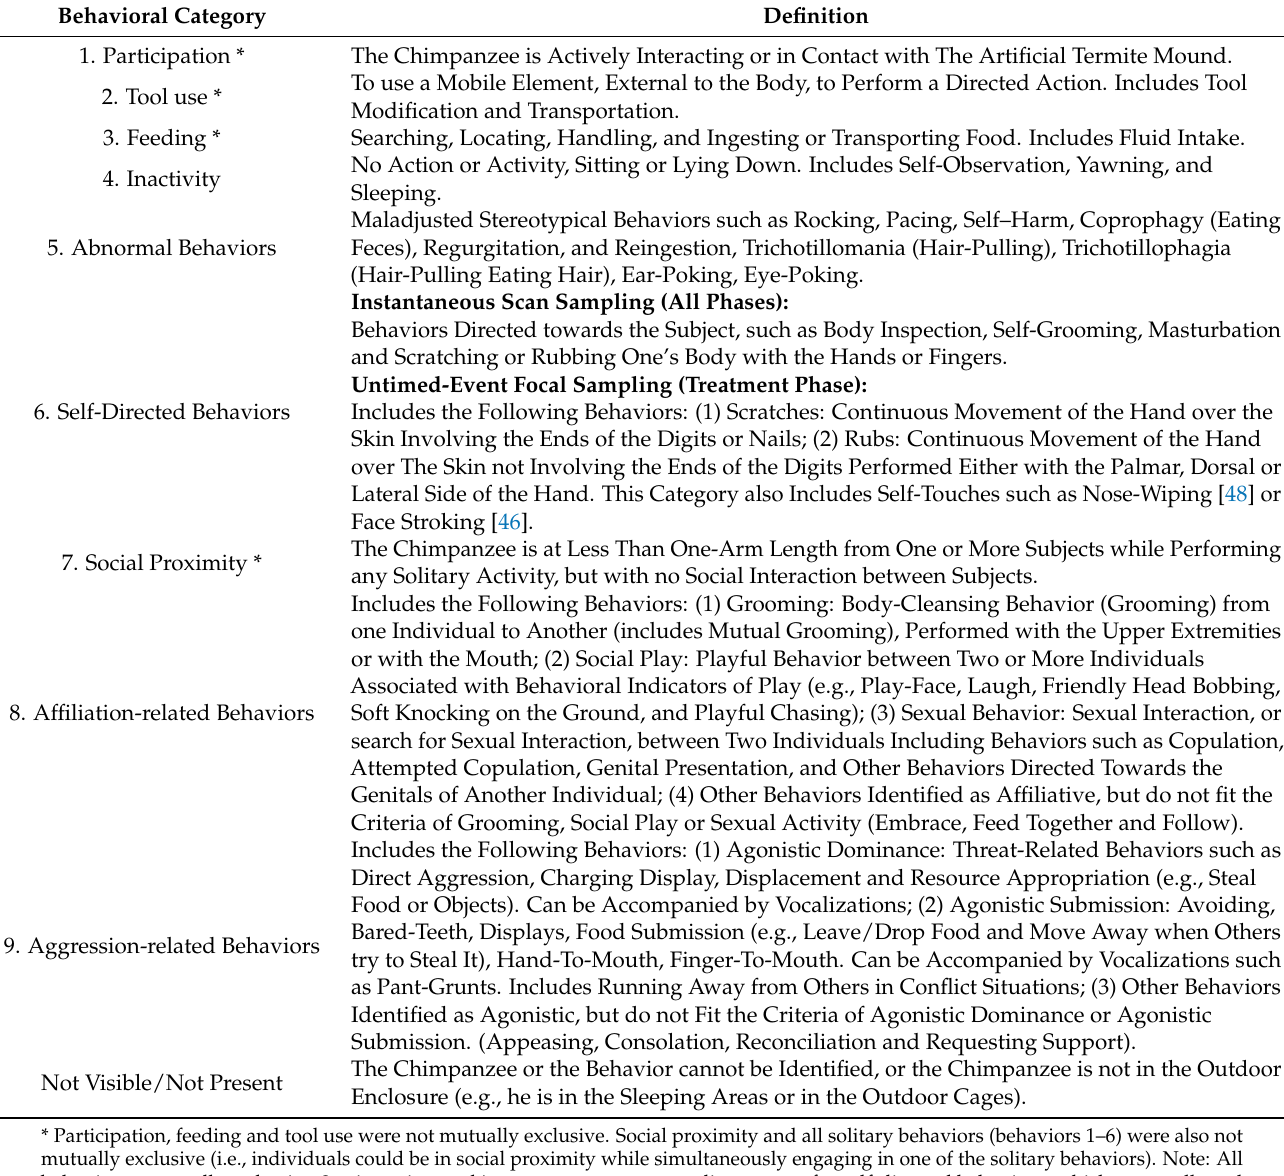
Table 1. Ethogram used during behavioral monitoring of